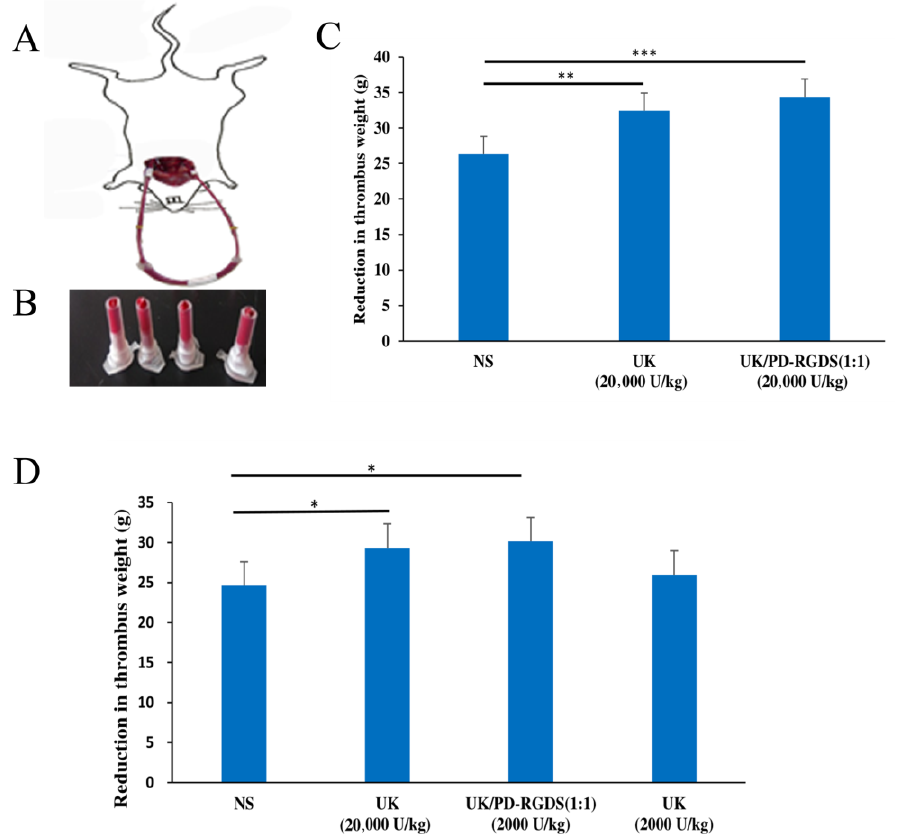
Figure 3. The assay on in vivo thrombolytic activity. ( A ) The in vivo rat model of carotid arteriove- nous bypass thrombolysis. ( B ) The thrombus was prepared first. ( C , D ) In vivo thrombolytic activity of commercial UK and UK/PD-RGDS complex at high dose of 20,000 U/kg ( C ), and at dose of 2000 U/kg ( D ) (n = 6). Notes: * p < 0.05; ** p < 0.01; *** p <